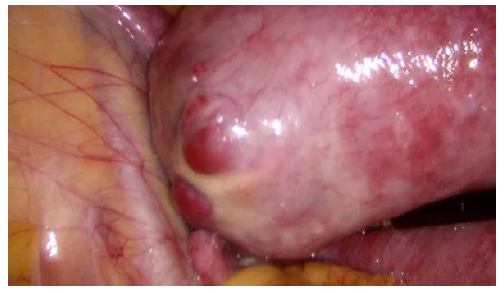
Figure 4. Left cornu of the uterus, observed during diagnostic laparoscopy.